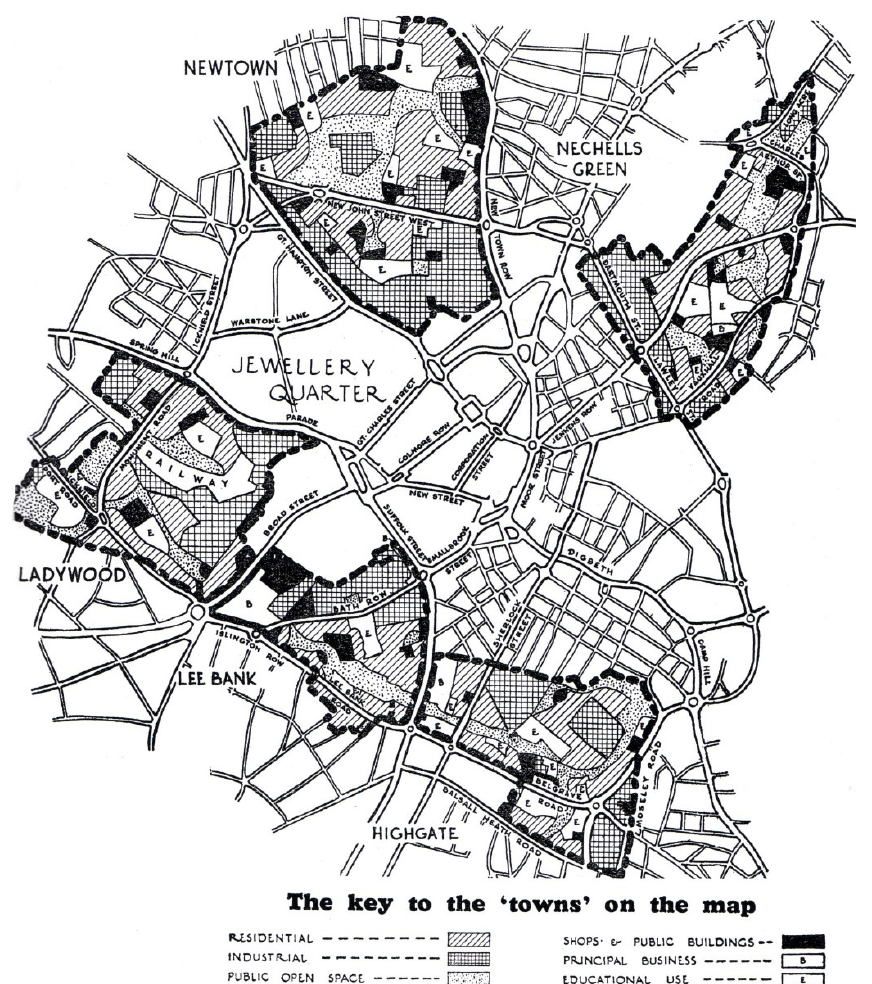
Figure 1. The five “new towns,” otherwise known as reconstruction areas. Source: Versions of this graphic, originally drawn by Manzoni’s department, were reproduced in many publications; this is from Price (1959, p.